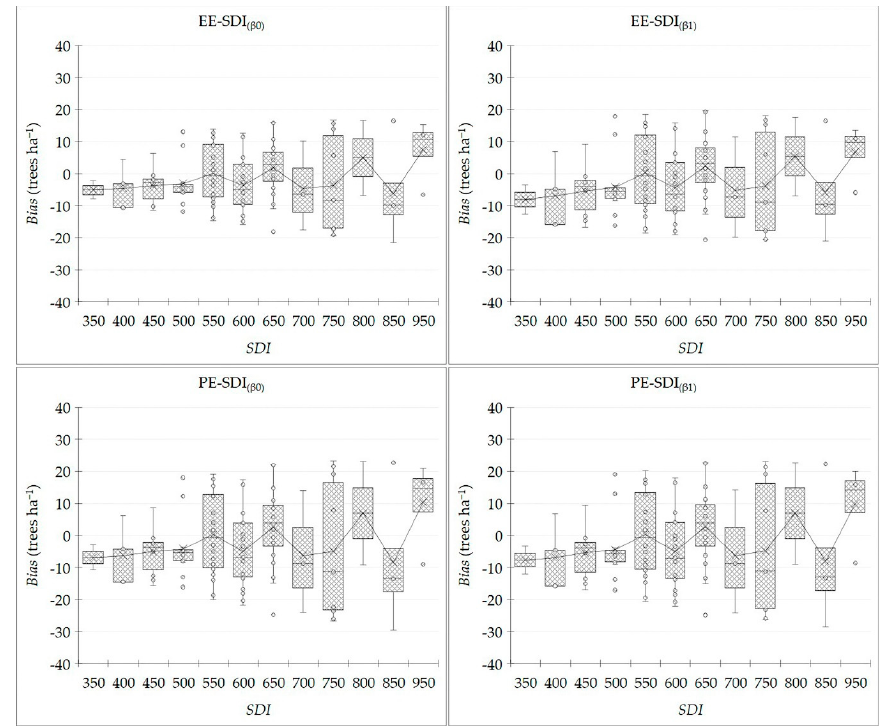
Figure 5. Bias presented via box-and-whisker plots for the SDI classes with exponential (EE-SDI ( β 0) and EE-SDI ( β 1) ; Equations (2) and (3), respectively) and potential (PE-SDI ( β 0) and PE-SDI ( β 0) ; Equations (7) and (8), respectively) equations for validation. In the box-and-whisker plots: “×” represents the mean of the residuals; “–” represents the median of the residuals; “vertical bar” represents the extreme residual values; the box represents the interquartile range (Q1–Q3); circles represent the inner and outlier points.